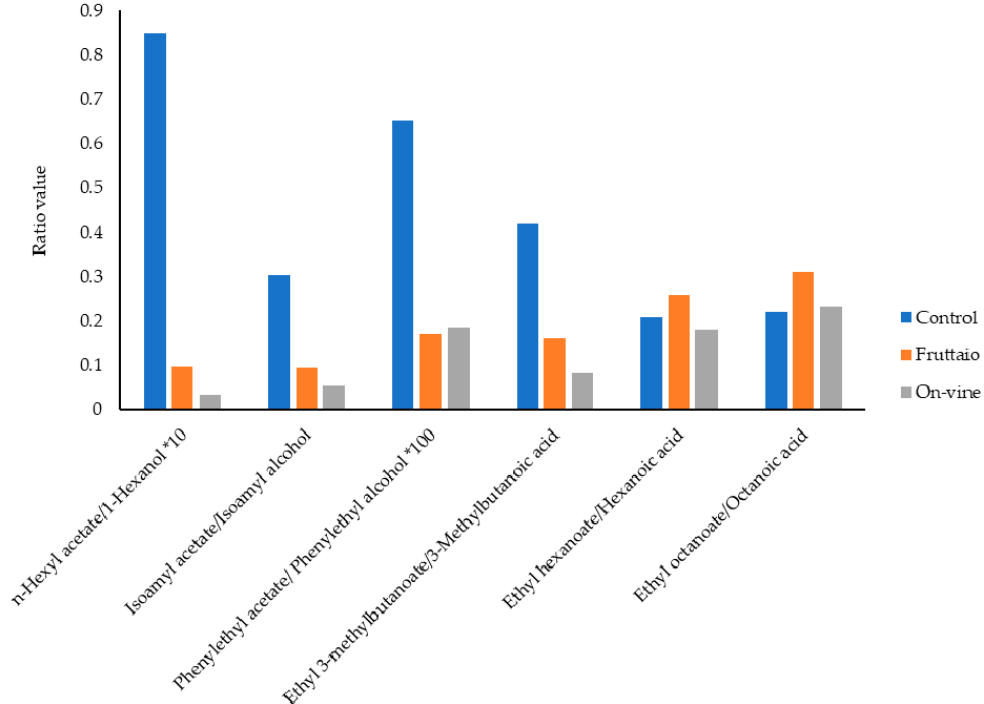
Figure 3. Ratio between esters and related precursors.